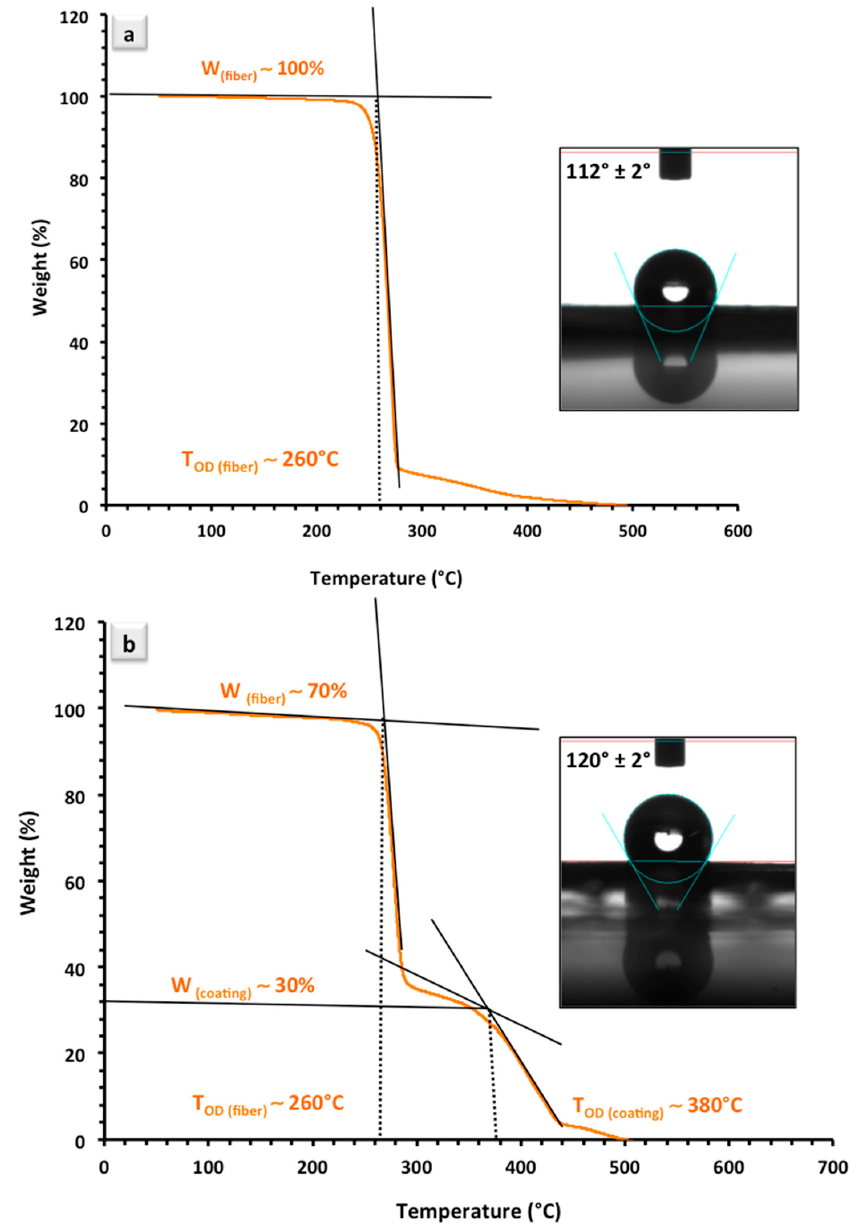
Figure 2. TGA and WCA analyses of: ( a ) uncoated; and ( b ) polymer coated PHB fibers. W and T OD in both TGA plots refer to the weight and temperature for the onset of degradation, respectively.